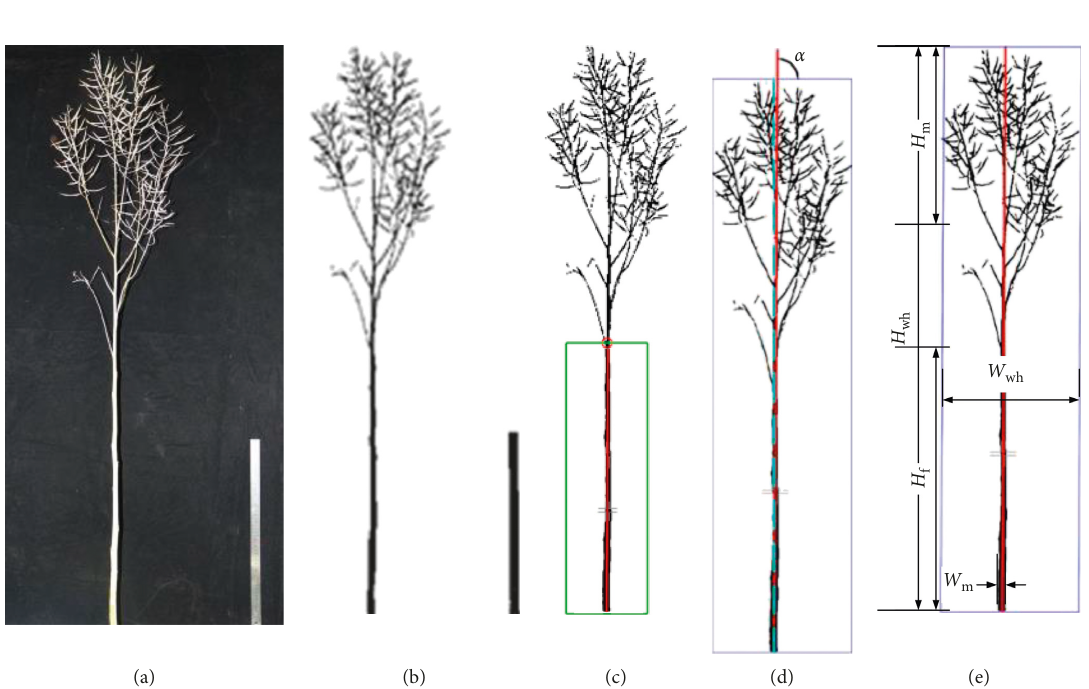
Figure 4: Image preprocessing. (a) Original color image. (b) Binary image. (c) Detection for primary branches, (d) Skew correction. (e) Geometric parameters of the plant.